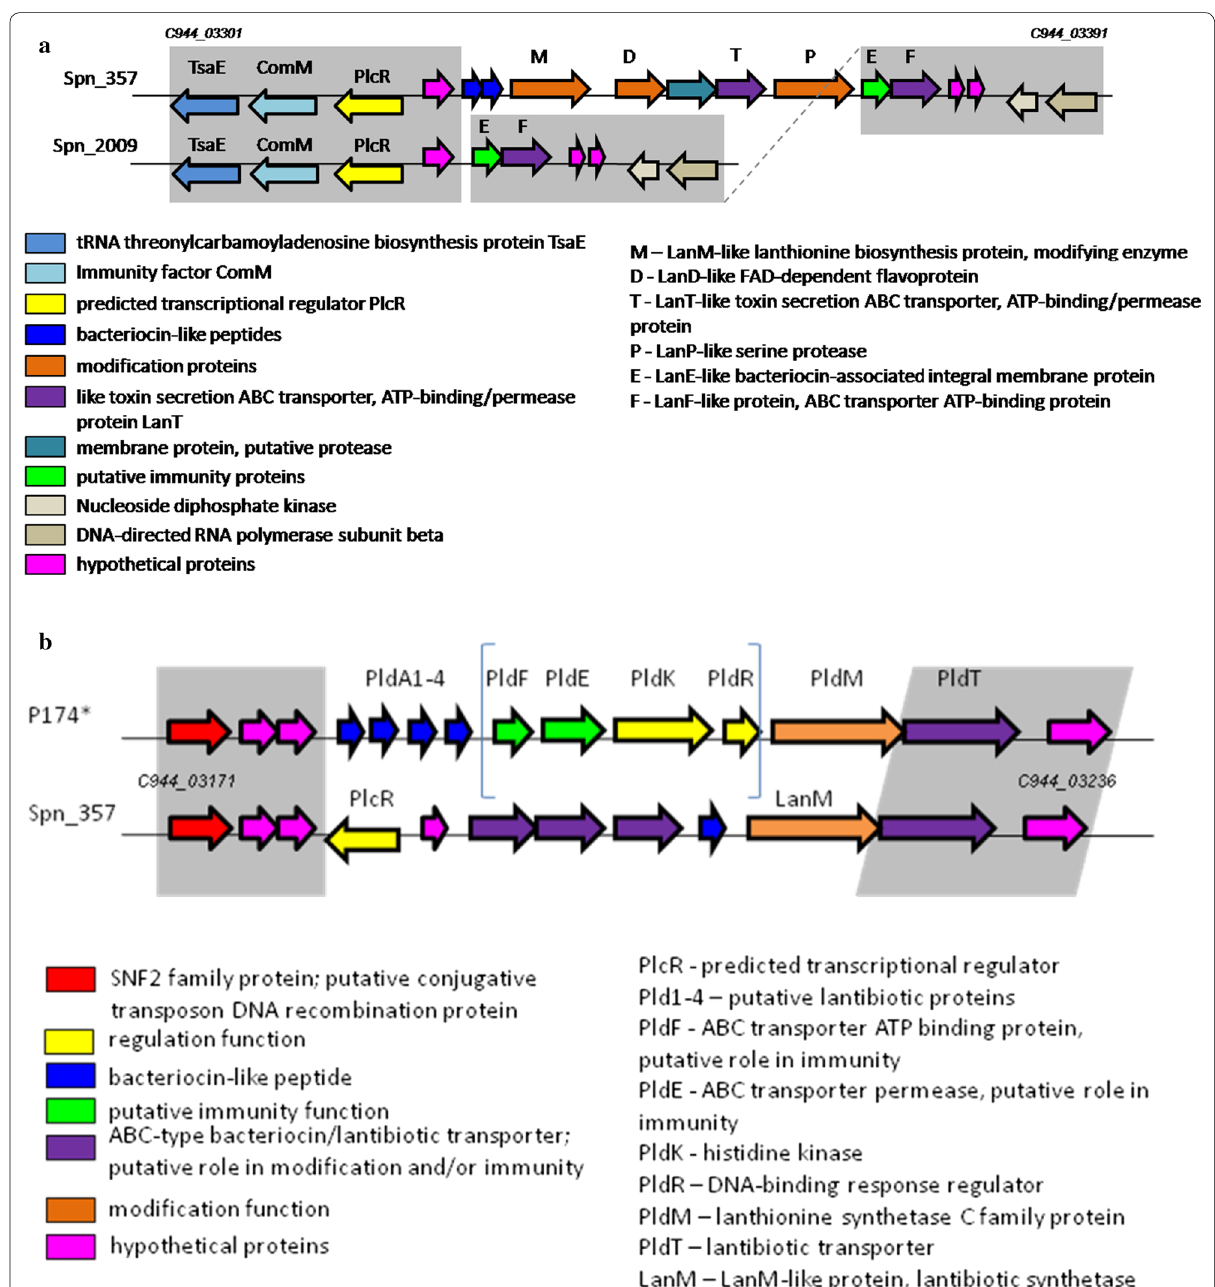
Fig. 2 Graphic representation of lantibiotic clusters I ( a ) and pld locus ( b ) based on the genome analysis of strains under study. *P174 is the strain described in the work (Maricic et al. 2016) where an unusual tandem of four lantibiotic-like genes was found out. Square brackets point a part of the pld locus found in S. mitis strains cluster IV gene locus (see text). Grey fields highlight homologous fragments in different